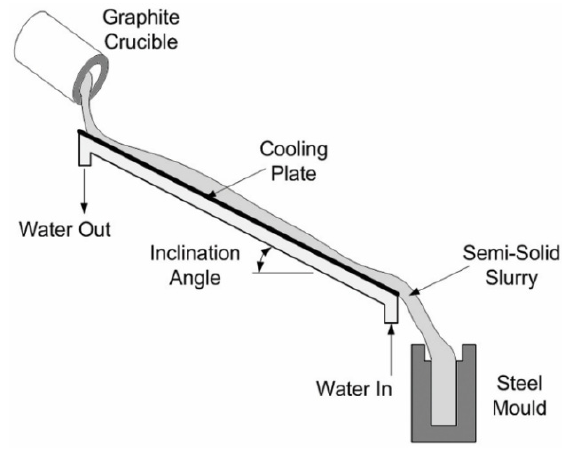
Figure 8. Schematic of the slope cooling technique for SSM processing [121]. Reprinted under the Creative Commons Attribution License (CC-BY) 4.0. Creative Commons Attribution License (CC-BY)